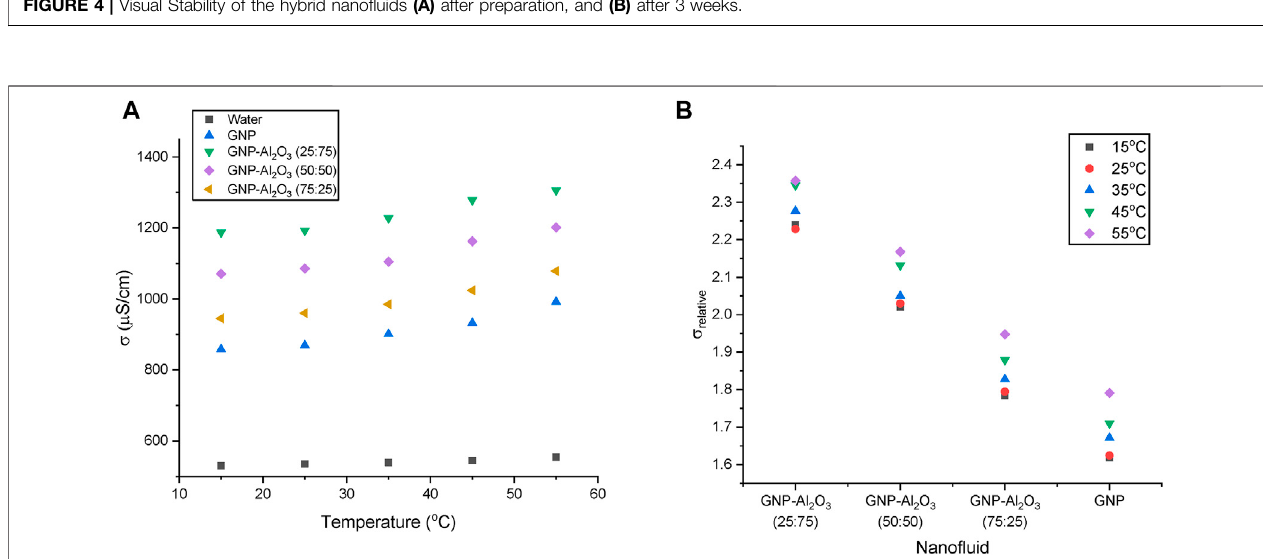
FIGURE 5 | (A) Electrical conductivity and (B) the relative electrical conductivity of the GNP-alumina hybrid nano fl uids for various mixing ratios at different temperatures.